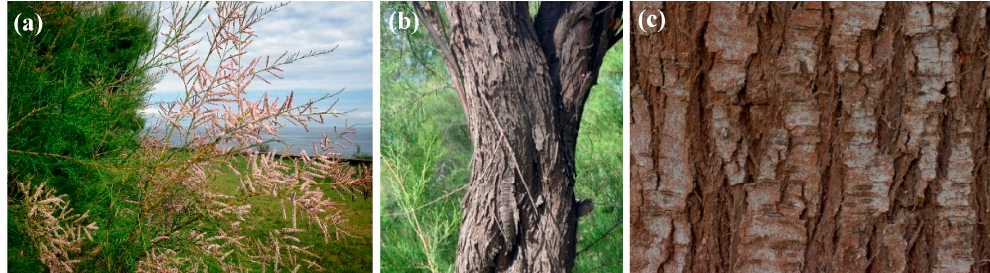
Figure 1. ( a ) Tamarisk of the Paseo de San Pedro , in Llanes (Asturias, northern Spain), ( b ) trunk of a T. gallica specimen, ( c ) detail of T. gallica bark.